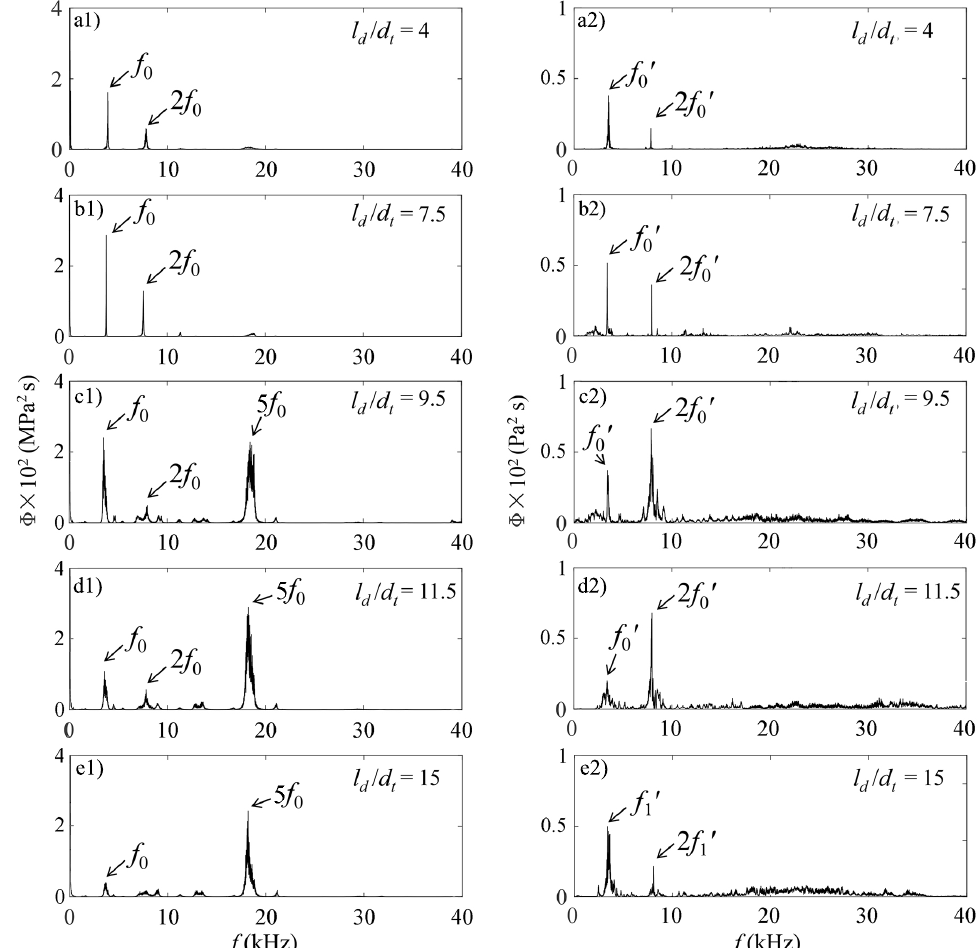
Figure 12. Spectra of the self-resonating oscillations (left column) and the cavitation noise (right column) at α = 5 ◦ . ( a1 , a2 ) l d / d t = 4; ( b1 , b2 ) l d / d t = 7.5; ( c1 , c2 ) l d / d t = 9.5; ( d1 , d2 ) l d / d t = 11.5; ( e1 , e2 ) l d / d t =